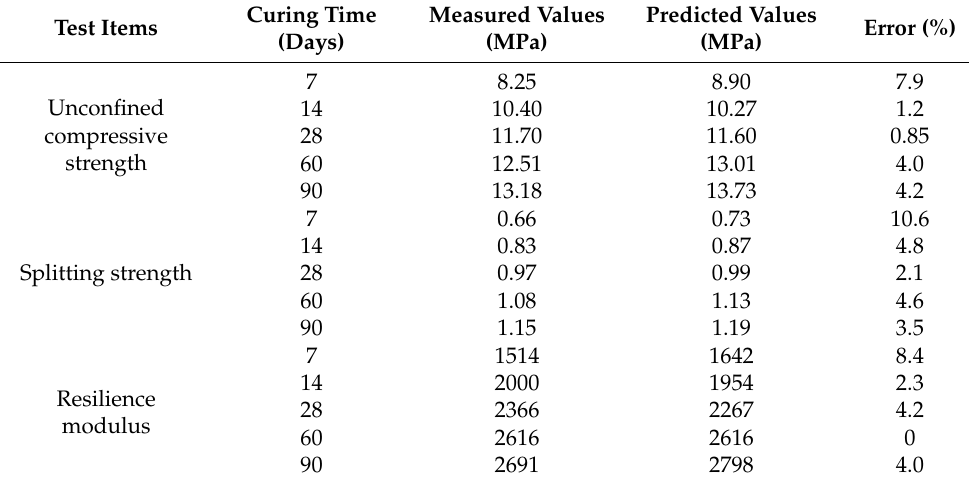
Table 12. The comparison of predicted and measured values. Test